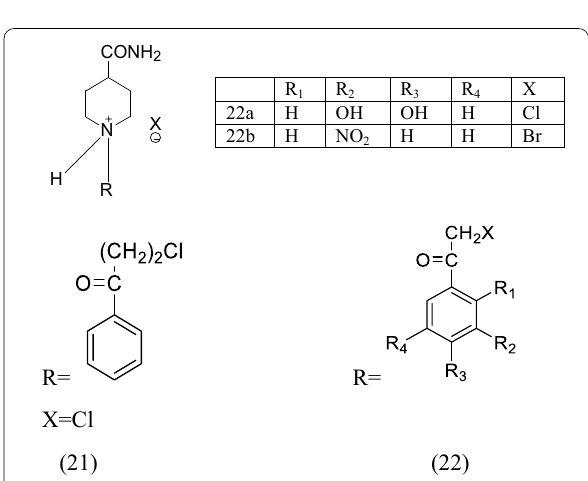
Fig. 26 Structure of N‑substituted phenacyl piperidine derivatives